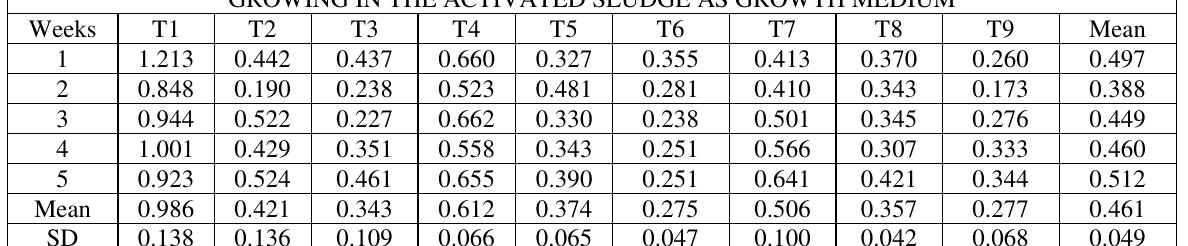
TABLE 4. EFFECT OF SELECTED PHCS ON THE BIOMASS (gL -1 DAY -1 ) OF ALGAL BIOFILMS GROWING IN THE ACTIVATED SLUDGE AS GROWTH MEDIUM